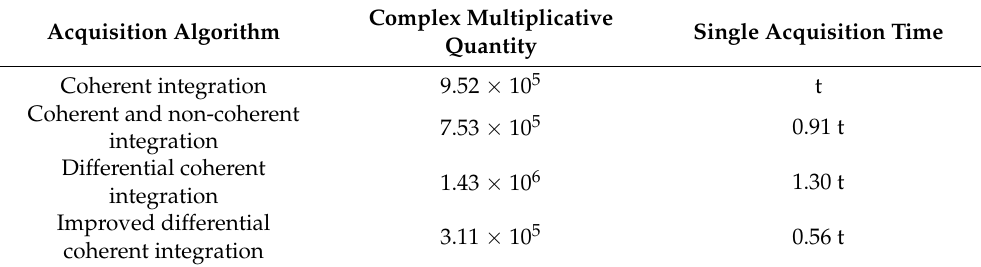
Table 2. The acquisition speed of the four algorithms.